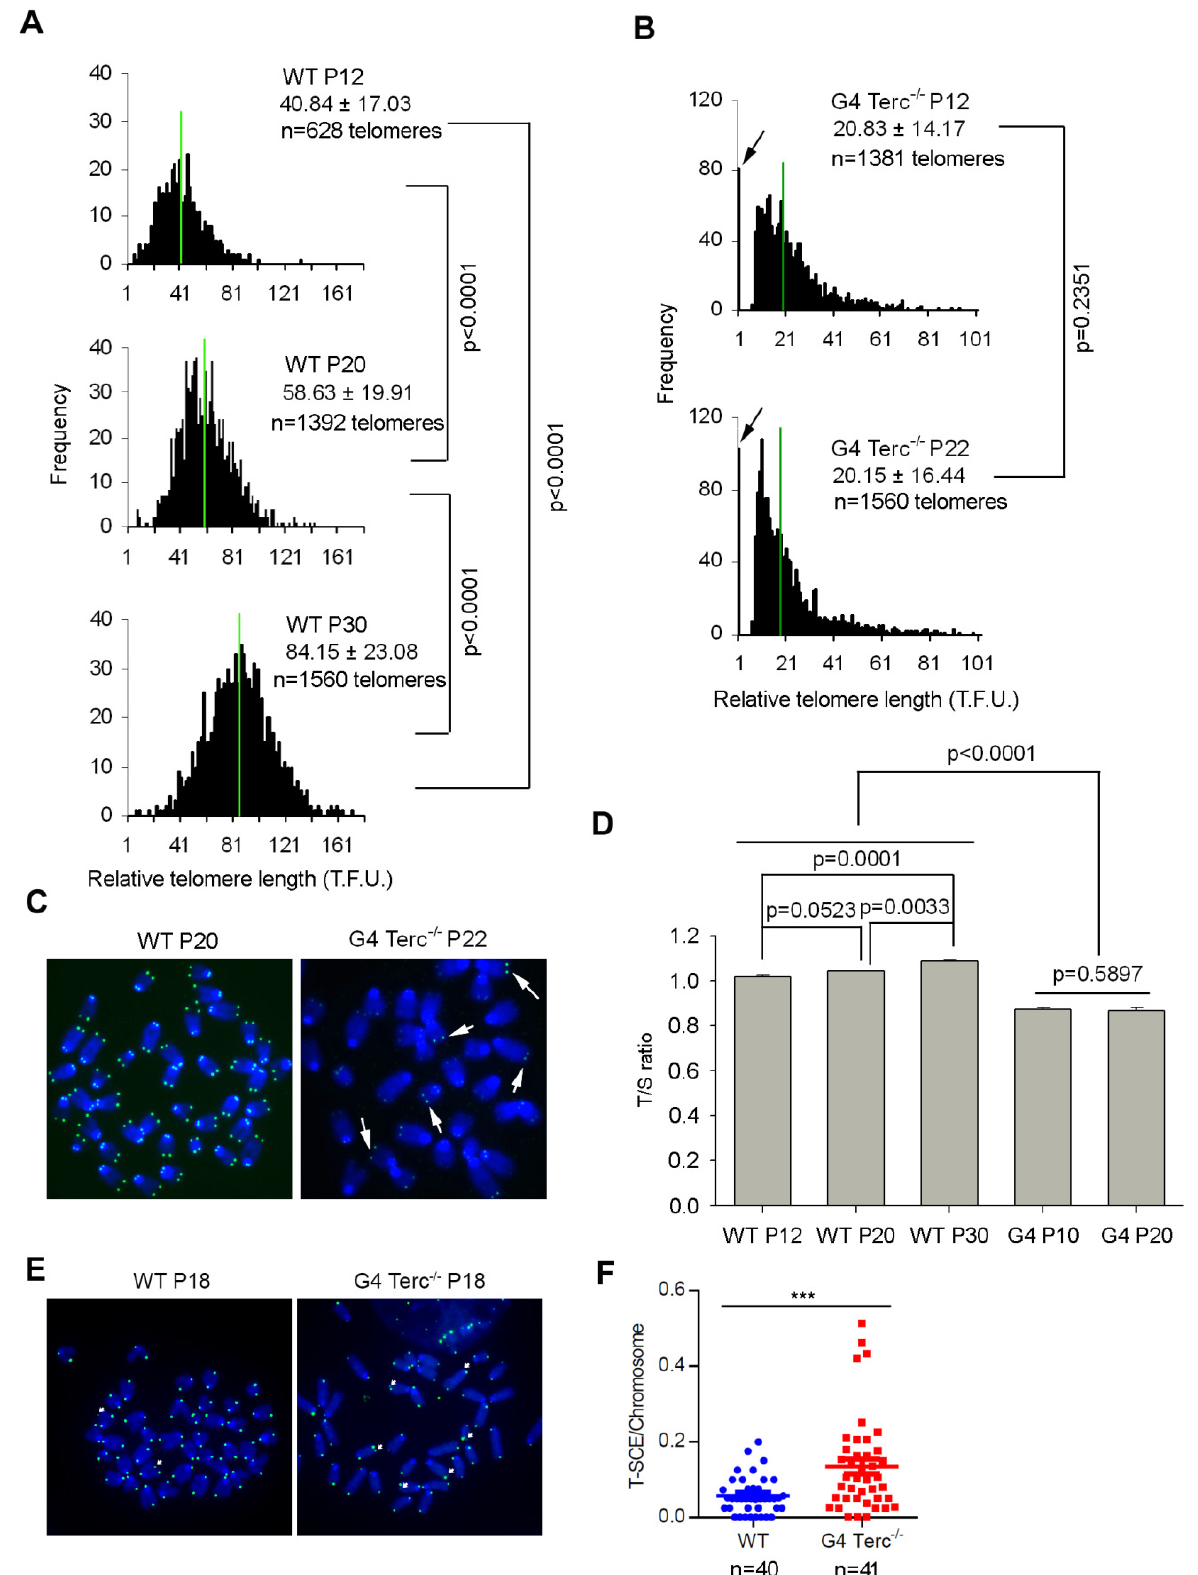
Figure 1. Telomere length dynamics in WT and G4 Terc ‐ / ‐ ES cells at different passages. ( A , B ) Distribution histogram of relative telomere length at different passages of WT ( A ) and G4 Terc ‐ / ‐ ( B ) ES cells, as analyzed by telomere Q ‐ FISH and the TFL ‐ TELO software. TFU, arbitrary telomere fluorescence unit. Green lines indicate medium telomere length. The average length ± SD is given in the upper right corner. Arrows indicate frequency of telomere loss. ( C ) Representative telomere ‐ specific PNA ‐ FISH image of WT P20 and G4 Terc ‐ / ‐ P22 ES cells. The G4 Terc ‐ / ‐ ES cells show typical ALT characteristics, with some telomeres longer than others shown with white arrow. ( D ) Relative